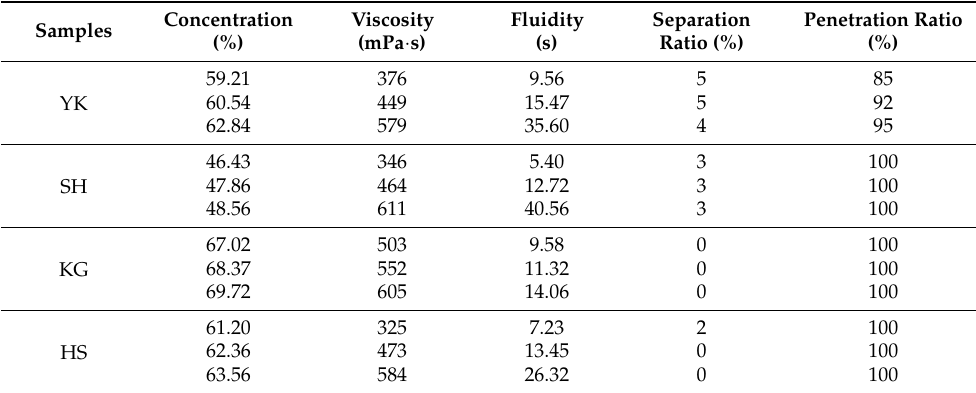
Table 6. Slurry properties of the four low-rank coals .